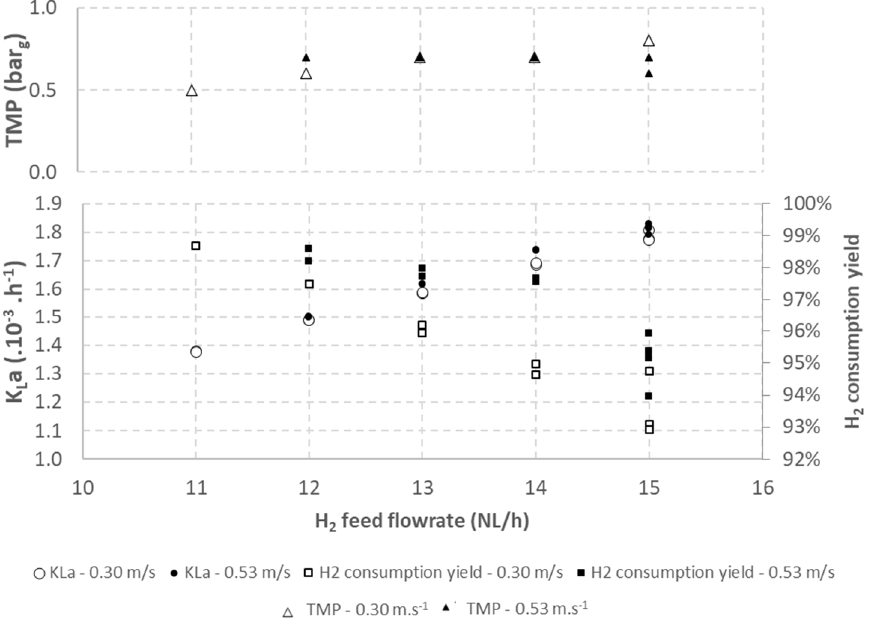
Figure 5. Impact of hydrogen feed flow rate on K L a.